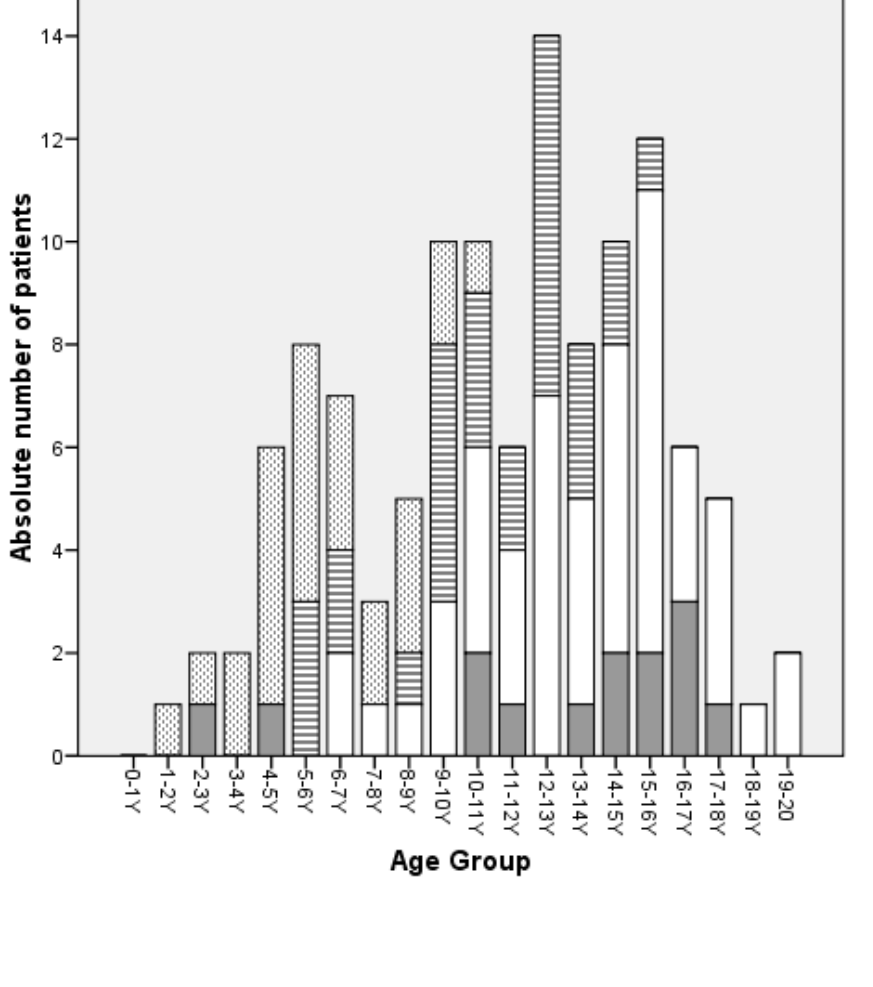
Figure 1 Age related use of different insulin treatment regimens in children and